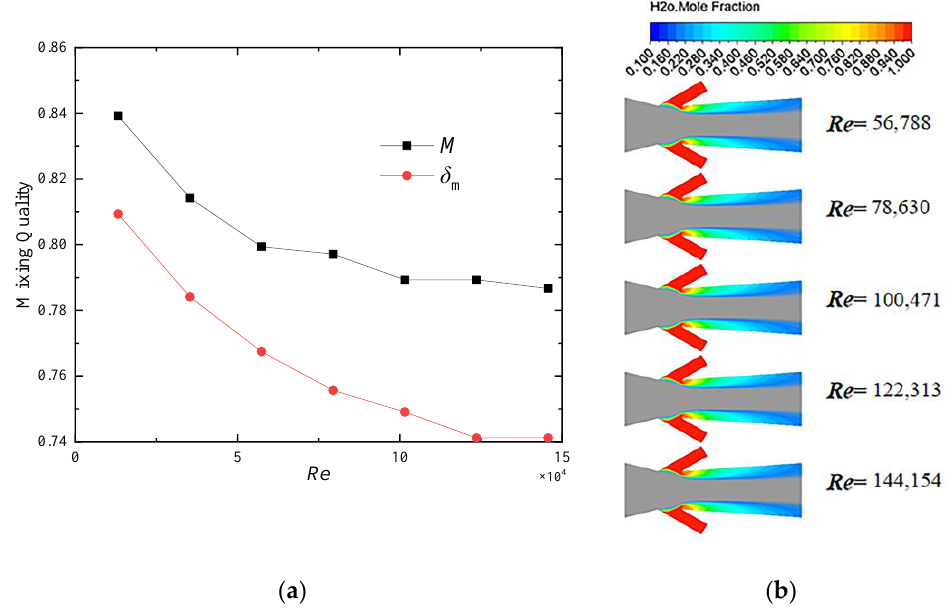
Figure 19. The effects of motive flow Reynolds number on ( a ) M and ( b ) concentration distribution of jetting flow in the VTM.